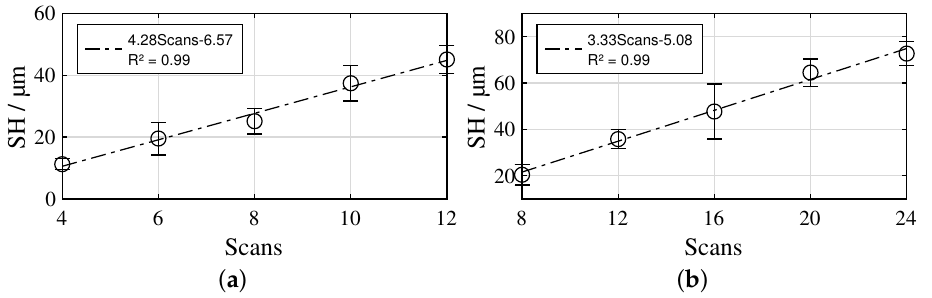
Figure 7. Correlation between the number of scans and SH : ( a ) L12 structures, ( b ) L40 structures; mean values ±